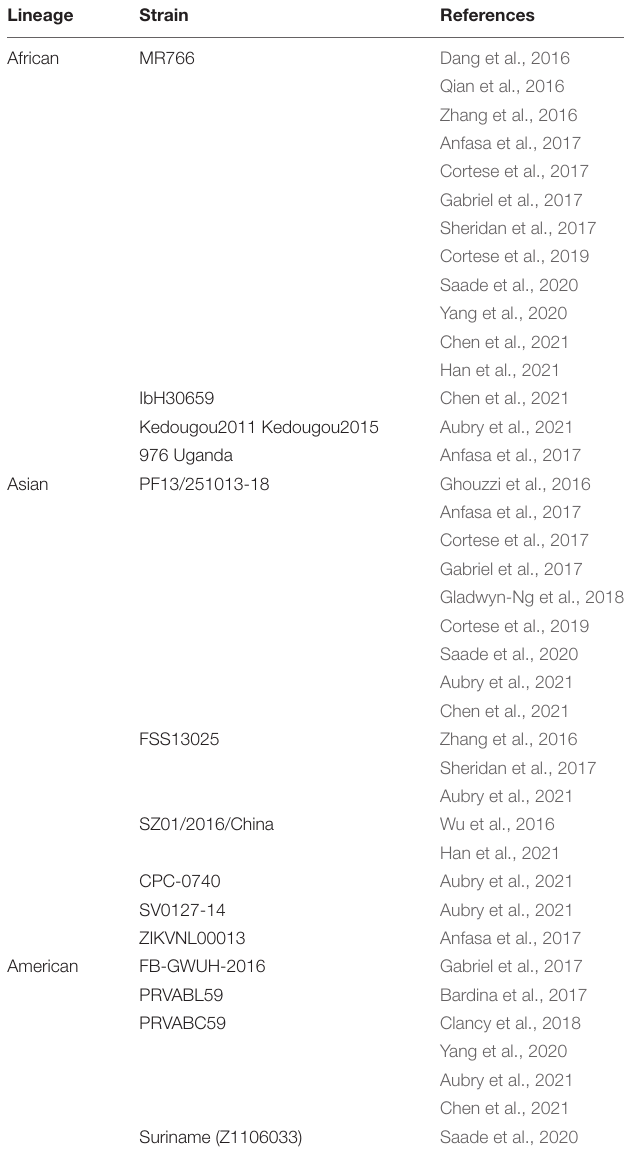
TABLE 1 | ZIKV strains used in the studies discussed in this